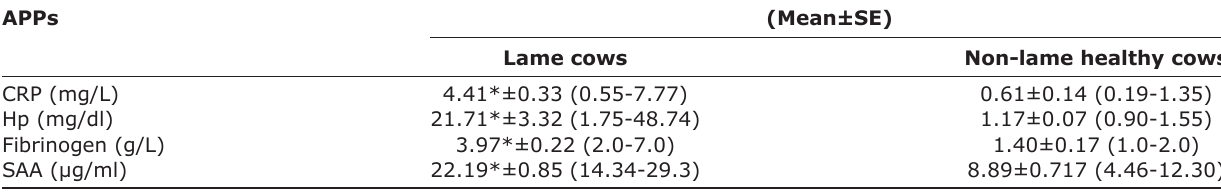
Table-1: Acute phase response in lame and non-lame healthy cattle. APPs (Mean±SE) Lame